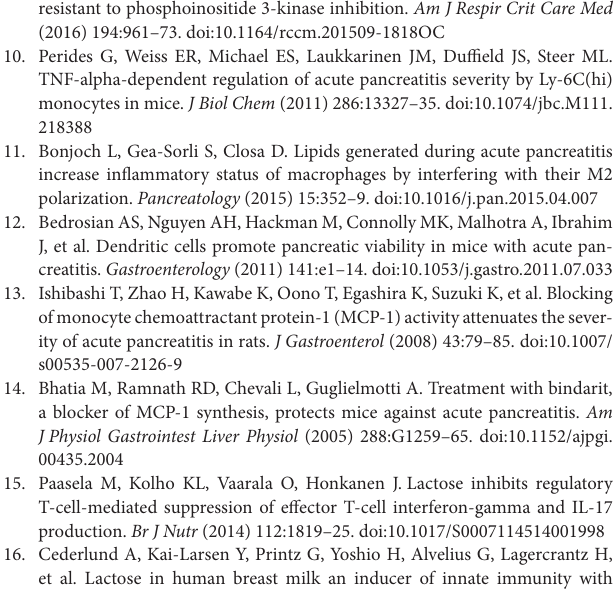
FigUre s1 | Lactose treatment modulates the severity of experimental AP-associated lung injury. Lung myeloperoxidase activity (a) and histology (B) were determined. Vehicle: saline treatment. Caerulein: caerulein hyperstimulation treatment. Prophylactic: lactose administered 30 min before starting caerulein treatment. Therapeutic: lactose administered 1 h after starting caerulein treatment. Data are mean ± SEM from at least three independent experiments of six to eight independent mice in each group. ** p < 0.01, *** p < 0.001 vs. vehicle by two-way analysis of variance. FigUre s2 | Effects of lactose on pancreatic B and T cells following acute pancreatitis induction. Female BALB/c mice were treated with caerulein together with or without lactose and 3 h later cells were recovered from the pancreas. Cells were directly stained for the expression of CD45, Ly6G, CD11b, CD19, and TCR β . B and T cell numbers per pancreas were shown. Results are representative or median values ± interquartile range from two independent experiments with a minimum of five independent